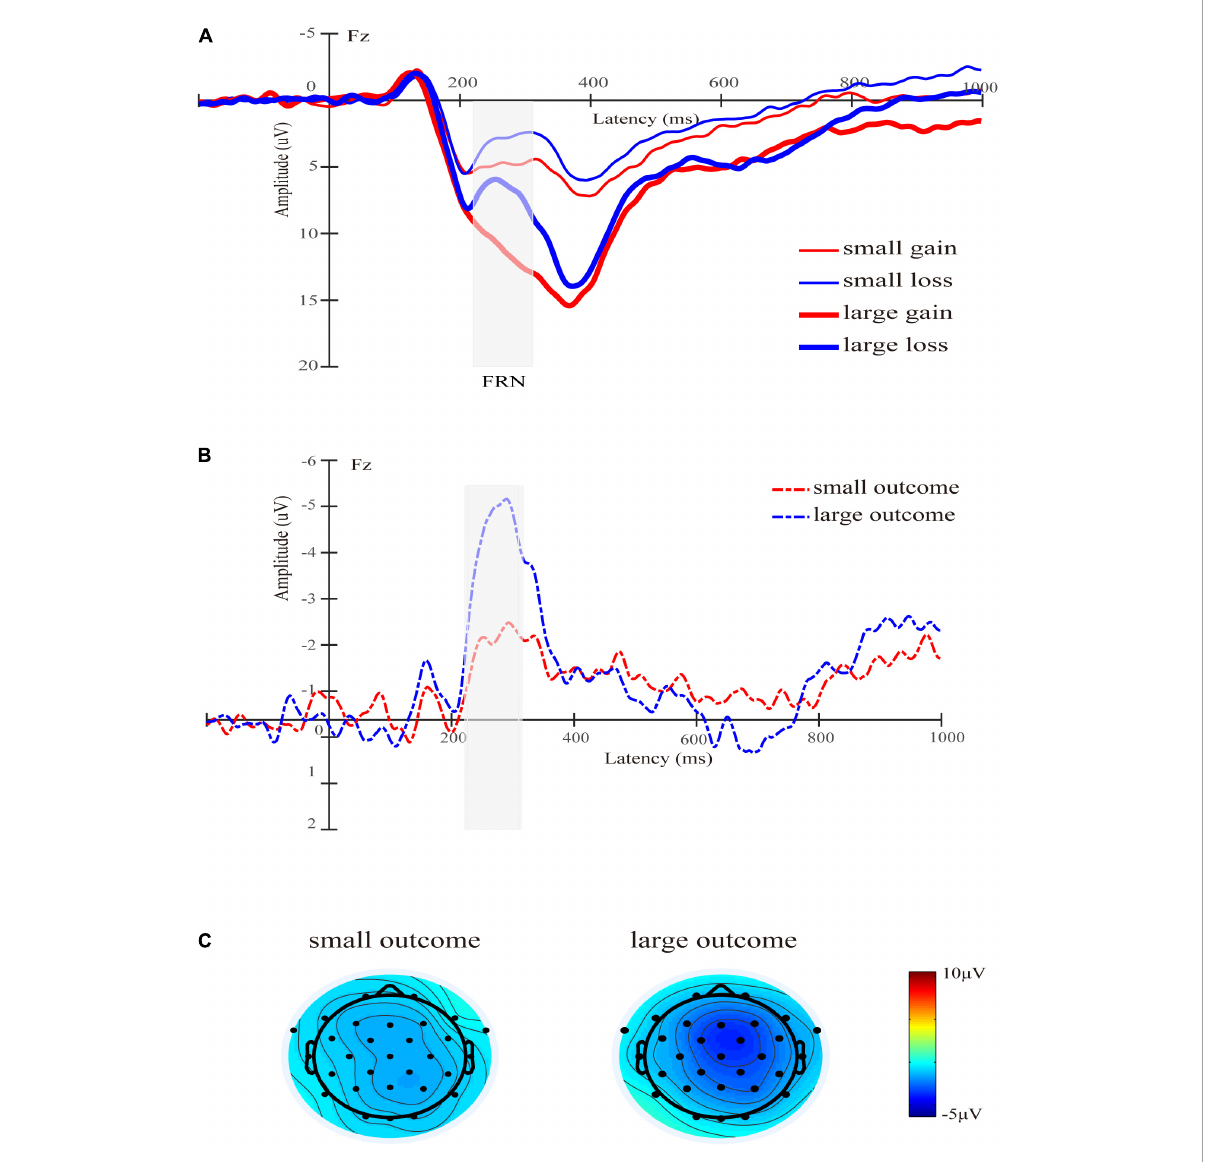
FIGURE3 (A) Grand-average ERP waveforms of FRN at Fz electrode site. The gray area highlights the 220–310 ms time window for calculating the mean value of FRN. The thin red line represents the waveform with a small gain condition, the thin blue line represents the waveform with a small loss condition, the thick red line represents the waveform with a large gain condition, and the thick blue line represents the waveform with a large loss condition. (B) The difference wave of FRN in the 220–310 ms time window (loss minus gain). (C) The scalp topographies of the difference for small and large outcomes are